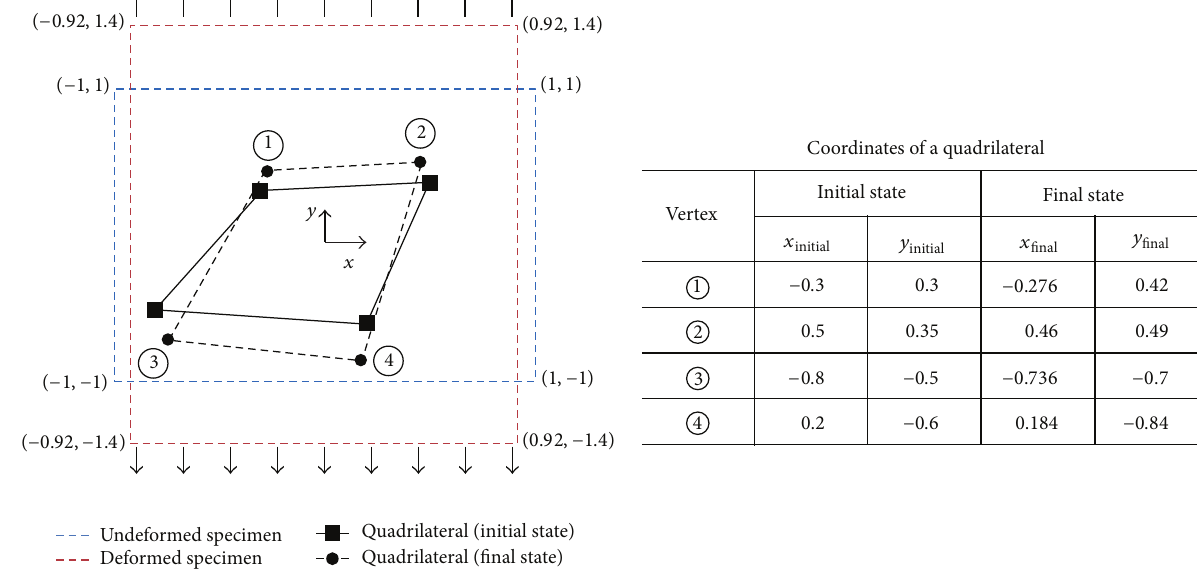
Figure 4: Coordinates of the four marker points before and after deformation.